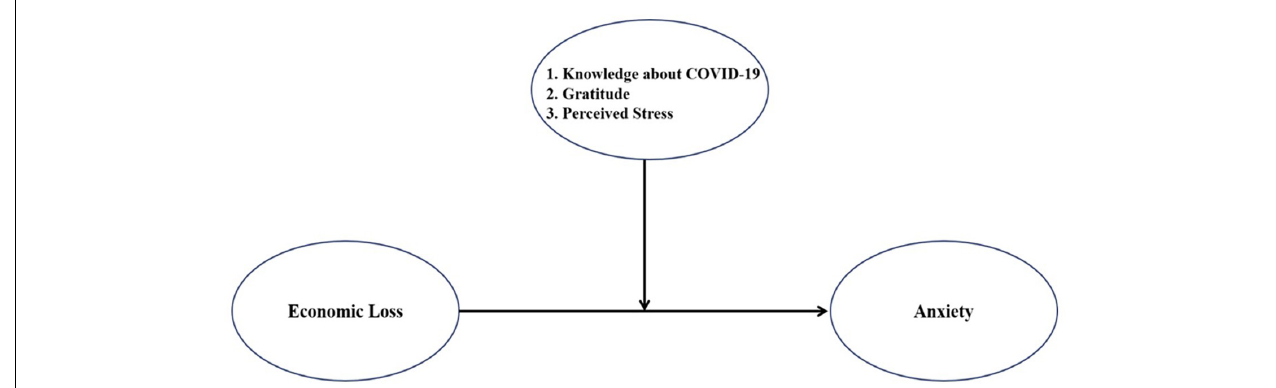
FIGURE 1 | A model of the moderating